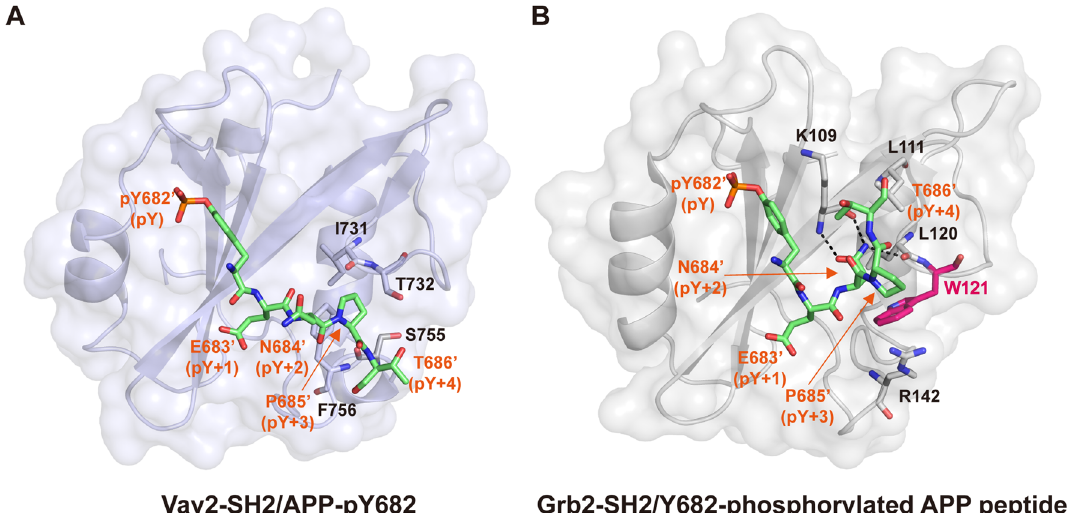
Figure 3. Comparison of the phosphopeptide-binding sites in Vav2-SH2 and Grb2-SH2. ( A , B ) The presentation of the structures of Vav2-SH2 complexed with APP-derived phosphopeptide ( 682 pY-ENPT 686 ) and Grb2-SH2 (PDB code: 3MXC). Vav2-SH2 domain (in purple) and Grb2-SH2 domain (in grey) are shown in ribbon and surface representation, APP-derived phosphopeptide (in green) and the side chains of crucial residues is shown in stick representation. Conformation of APP-pY682 as seen in complex with Vav2-SH2 domain is hindered by W121 (in red) of EF loop and BG loop when bound to the Grb2-SH2 domain. Selected hydrogen bonds are colored in